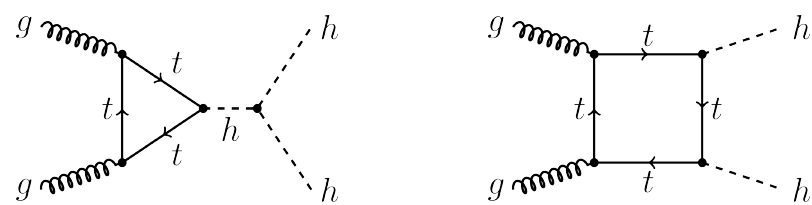
Figure 1. Generic diagrams for the triangle and box contributions to the pair production of Higgs bosons in gluon-gluon